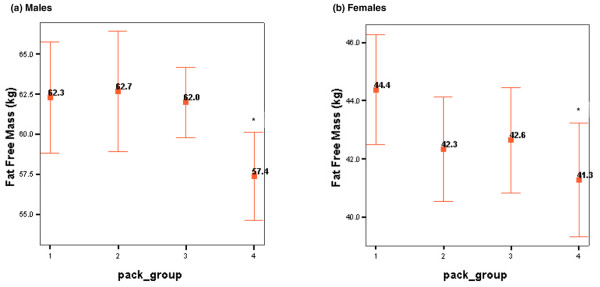
Fat-free mass for males (a) and females (b) according to pack-year grouping. Data are presented as means with 95% confidence intervals. Pack-year groups: 1, 1 to 9 pack-years; 2, 10 to 19 pack-years; 3, 20 to 34 pack-years; 4, greater than 35 pack-years. Asterisk indicates significant difference compared with group 1 (P < 0.05).